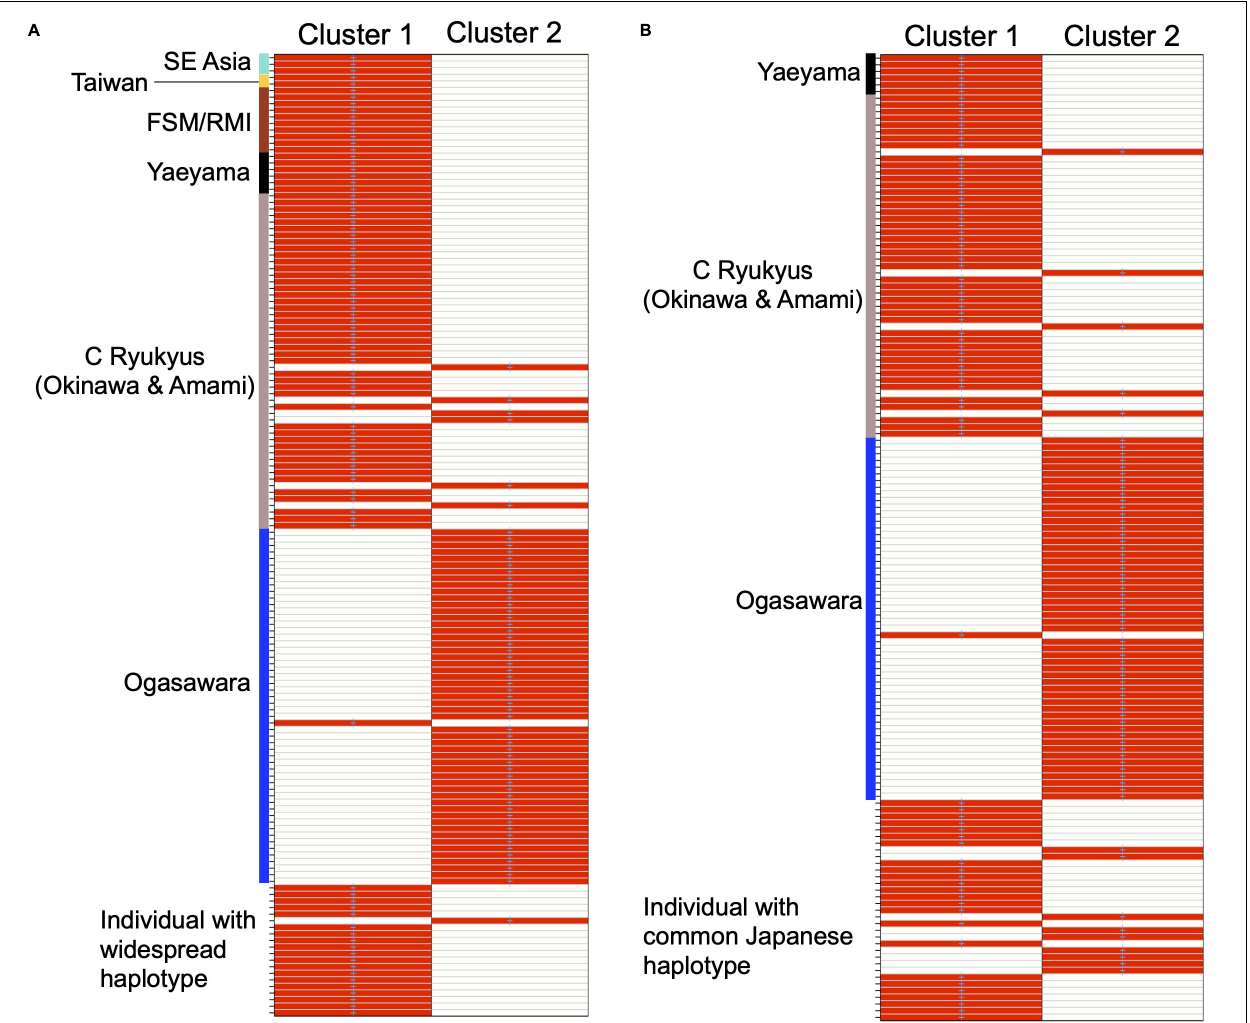
FIGURE 4 | Results of the group assignments of the turtles carried out with 20 individuals with widespread haplotypes and 126 origin identified individuals [SE Asia, Taiwan, Yaeyama, C Ryukyus (Okinawa and Amami combined), and Ogasawara] based on 1,093 SNPs (A) and carried out with 33 individuals with common Japanese haplotypes and 111 origin identified individuals [Yaeyama, C Ryukyus (Okinawa and Amami combined), and Ogasawara] based on 2,326 SNPs (B) , respectively. Heat colors represent membership probabilities (red = 1, white = 0); blue crosses represent the prior cluster provided to DAPC by the find.clusters function. Blue crosses on red rectangles show that the individuals successfully reassigned to the prior clusters based on the discriminant functions.